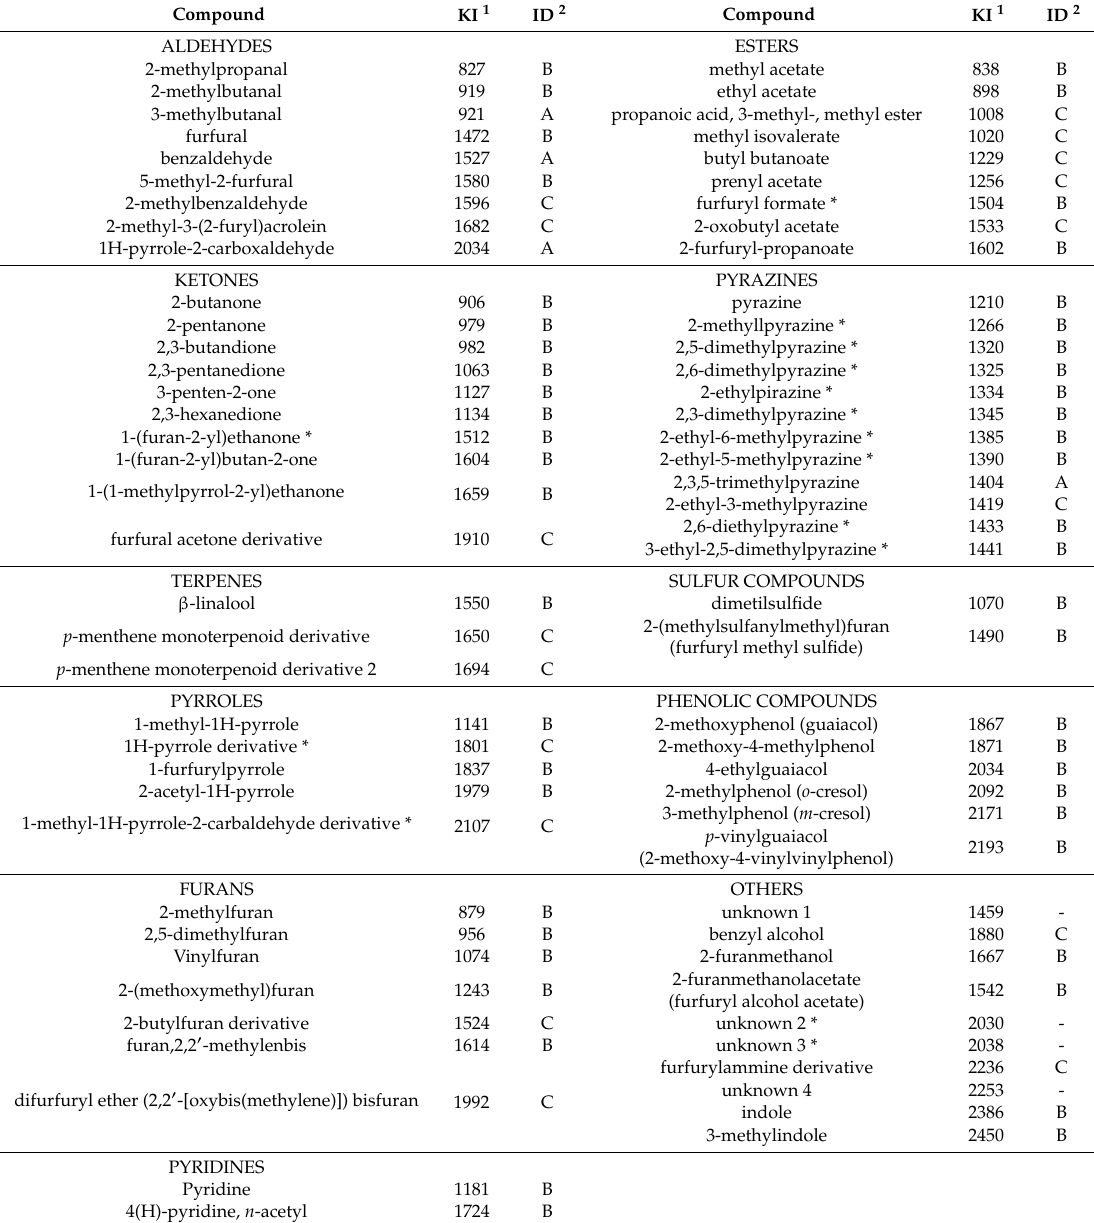
Table 1. Volatile compounds detected in espresso co ff ees (EC) samples by headspace solid-phase microextraction (HS-SPME) / gas chromatography–mass spectrometry